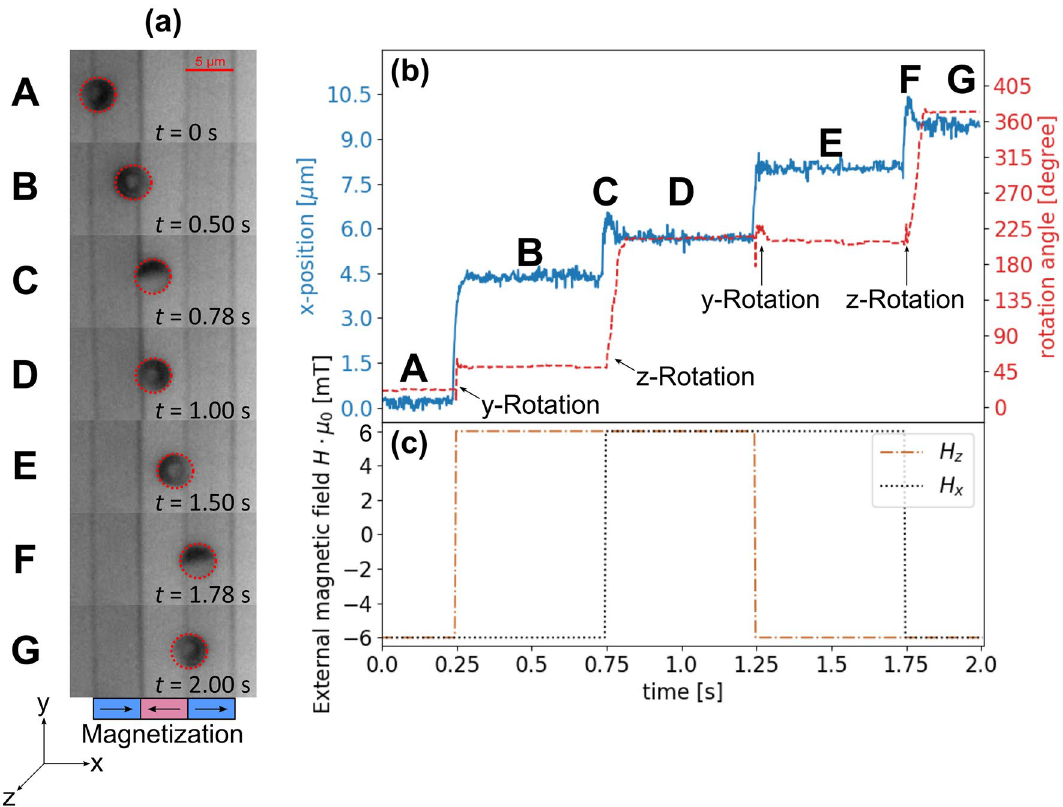
Figure 3. Directed transport of exchange-biased, magnetic Janus particles (MJPs) by the superposition of parallel-stripe static magnetic stray field landscapes and weak external magnetic field pulses. ( a ) Microscopy snapshots (A–G) for the different phases of the externally applied magnetic field pulse sequence ( c ). ( b ) Position (blue solid line) and cap orientation with respect to the z-axis (red, dashed line) determined from particle tracking in the respective videos. The stripe structure, optically visible in the microscopic images is the lithographically patterned resist left behind to mark the positions of the magnetic domains within the underlying substrate. The tracking data reflects the visually observable fast translational and rotational motion of the MJP induced by a change of the external magnetic field in z - (brown, dot dashed line) and x -direction (black, dotted